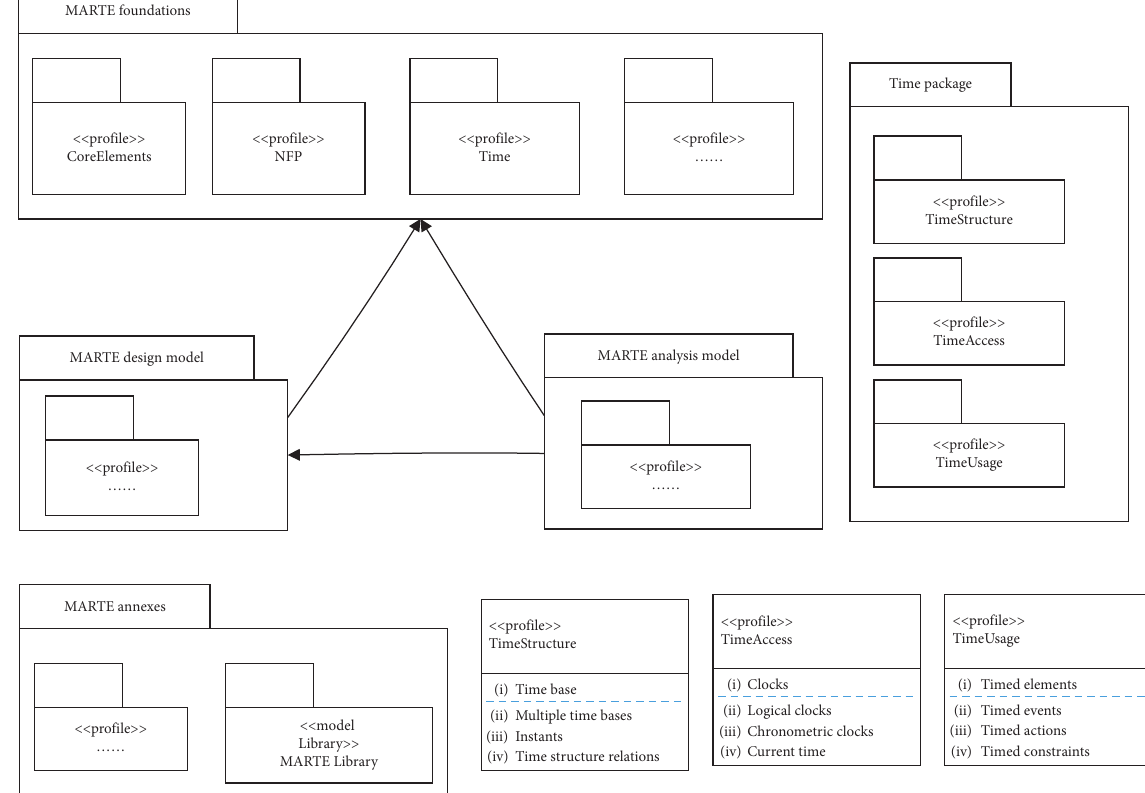
Figure 2: View of MARTE architecture and time